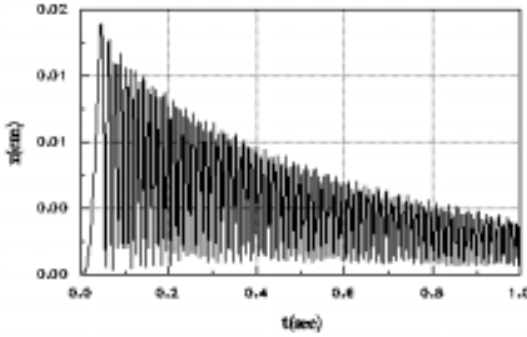
Fig. 3. The standard variance of displacement x 1 .